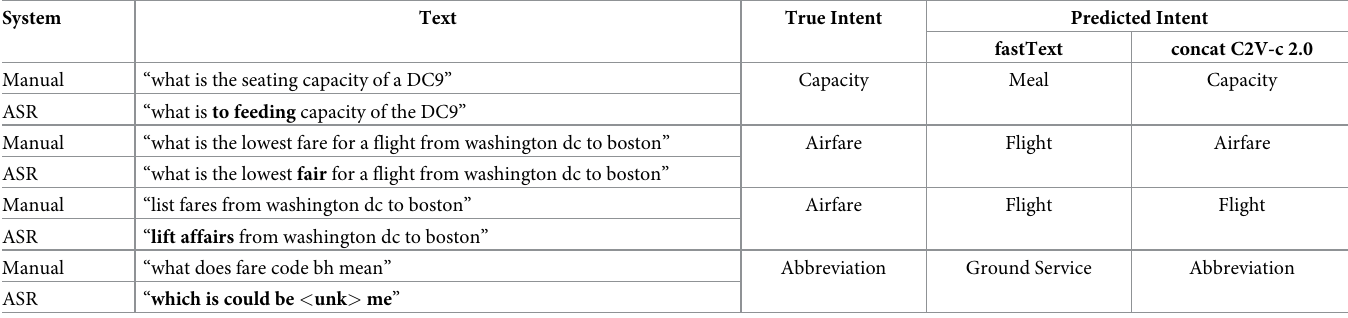
Table 4. Examples of intent detection: Trained on clean reference text, evaluated on ASR transcripts.